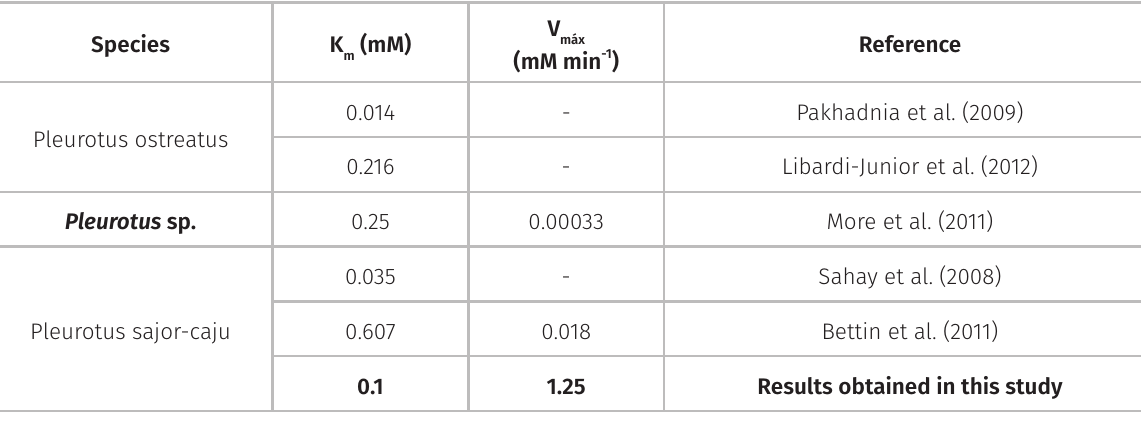
Table V. Effectiveness values of different studies on BPA removal by Pleurotus